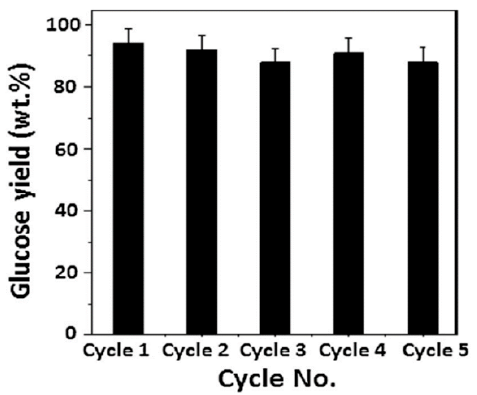
Figure 5. Hydrothermal conversion of agricultural wastes, namely, Cicer arietinum (CA), cotton, Pi- nus radiata cones (PR) and sugar cane bagasse, to levulinic acid. Adapted with permission from RSC [70].